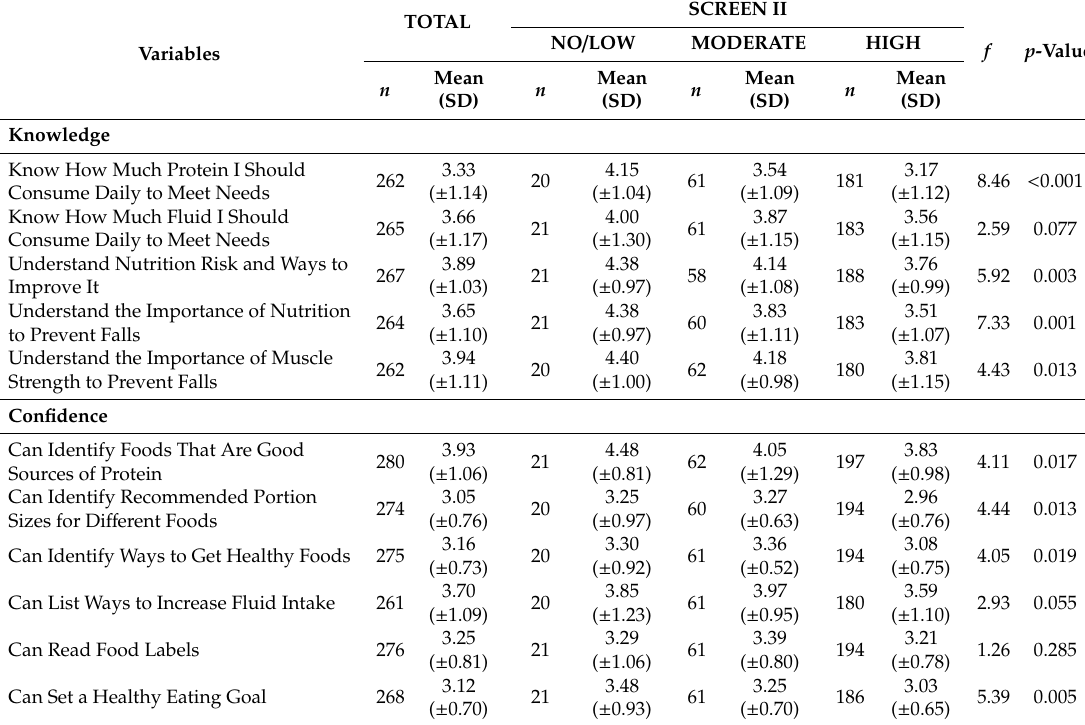
Table 3. Knowledge and Confidence for SUYN Participants by Malnutrition Risk